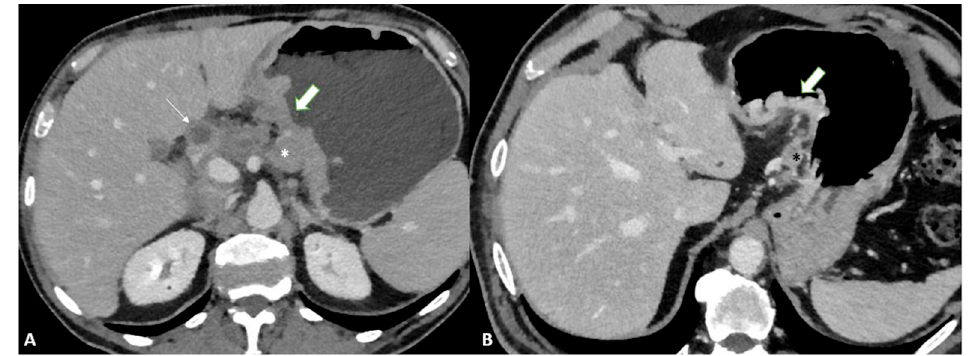
Figure 4. ( A ) Axial 2D image in the portal venous phase of a T4a gastric cancer in a 66-year-old female patient. The tumor (thick arrow) is the enhanced wall thickening in the lesser curvature side of the middle body of the stomach which penetrates the serosa with some solid deposits (white asterisk) in the perivisceral fat tissue and some pathologic lymph nodes (thin arrow) with necrotic-colliquative components inside. ( B ) Axial 2D image of a T4a gastric cancer in a 78-year-old female patient. The tumor (thick arrow) is the enhanced wall thickening on the lesser curvature side of the low body of the stomach which penetrates the serosa with some spiculatures in the perivisceral fat tissue and a pathologic lymph node (black asterisk).